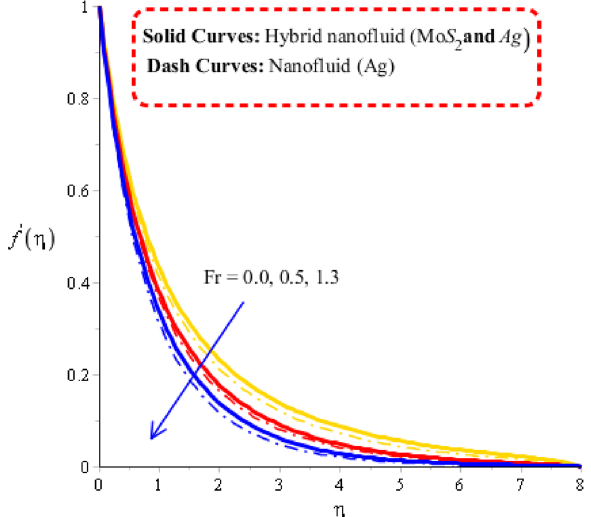
0.23, (cid:31) 0.2, γ 1.3, Pr 204, Hs 1.3, (cid:31) 1.2, ∗ = = = = = − =